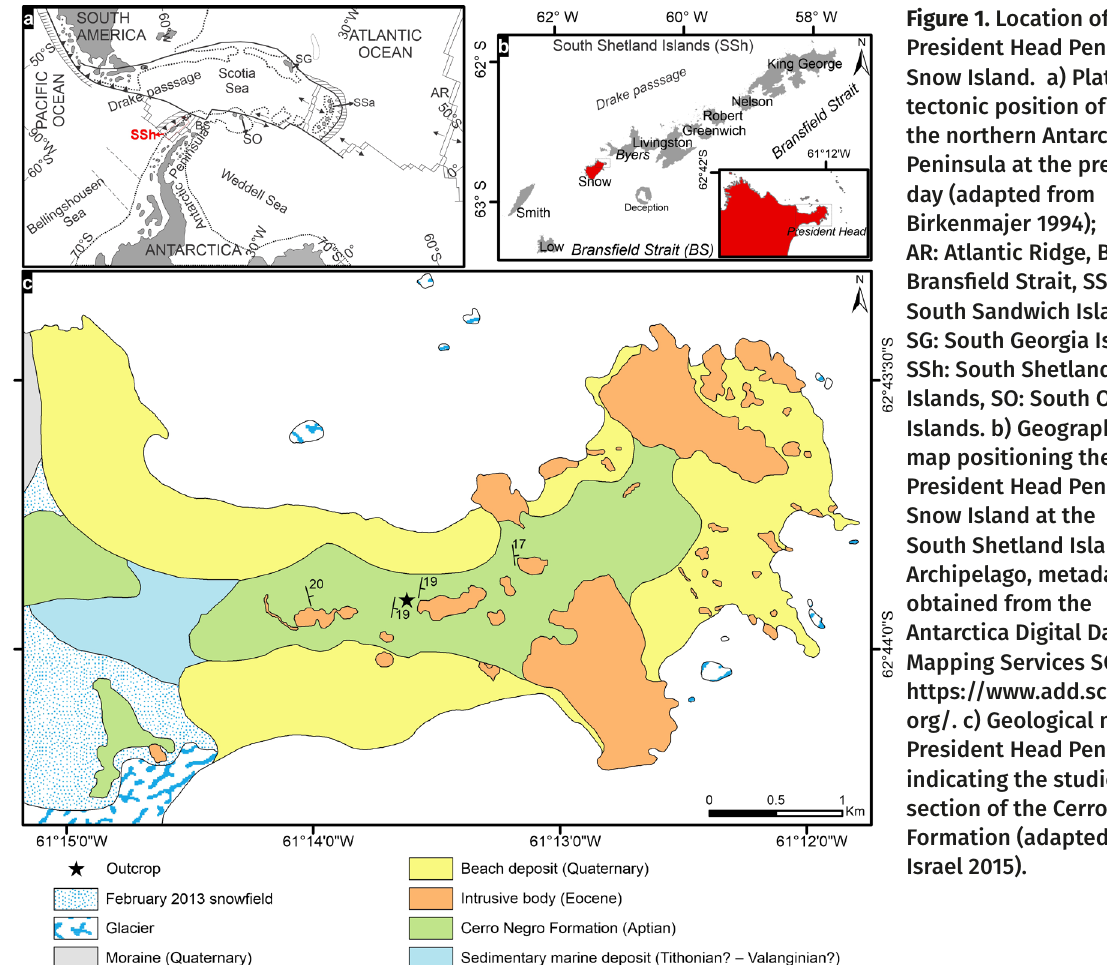
Figure 1. Location of President Head Peninsula, Snow Island. a)